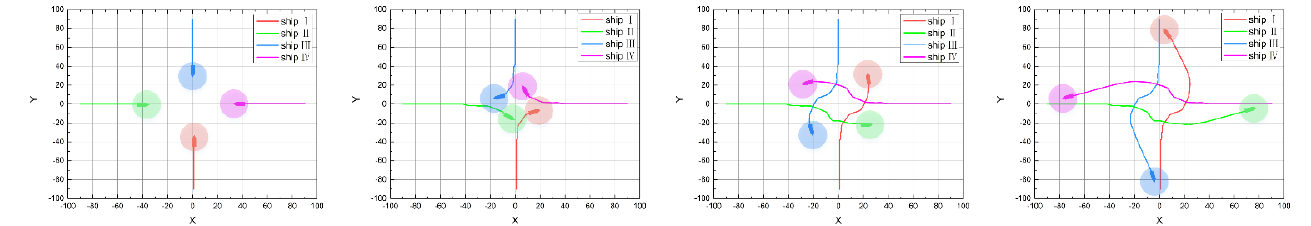
Figure 16. Four ships encountering scenario. (Unit: 10 m).